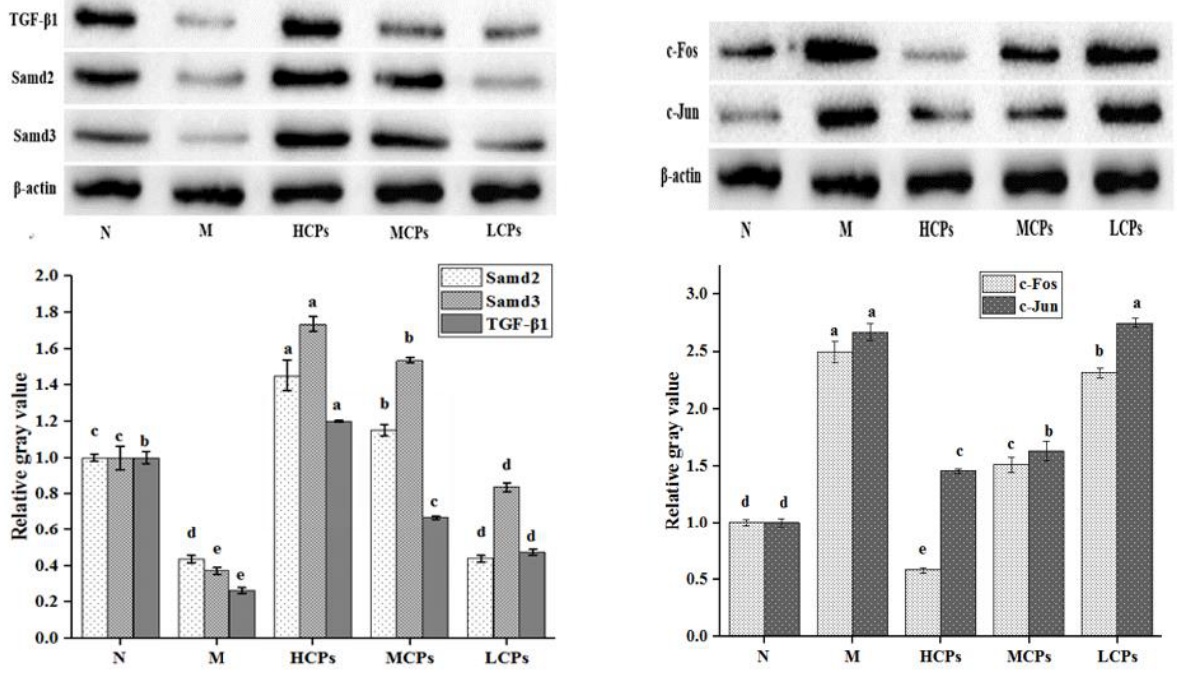
Figure 6. Effects of CPs on the TGF-B/Smad signaling pathway and AP-1 protein. Different letters in the same column indicate significant differences ( p < 0.05).